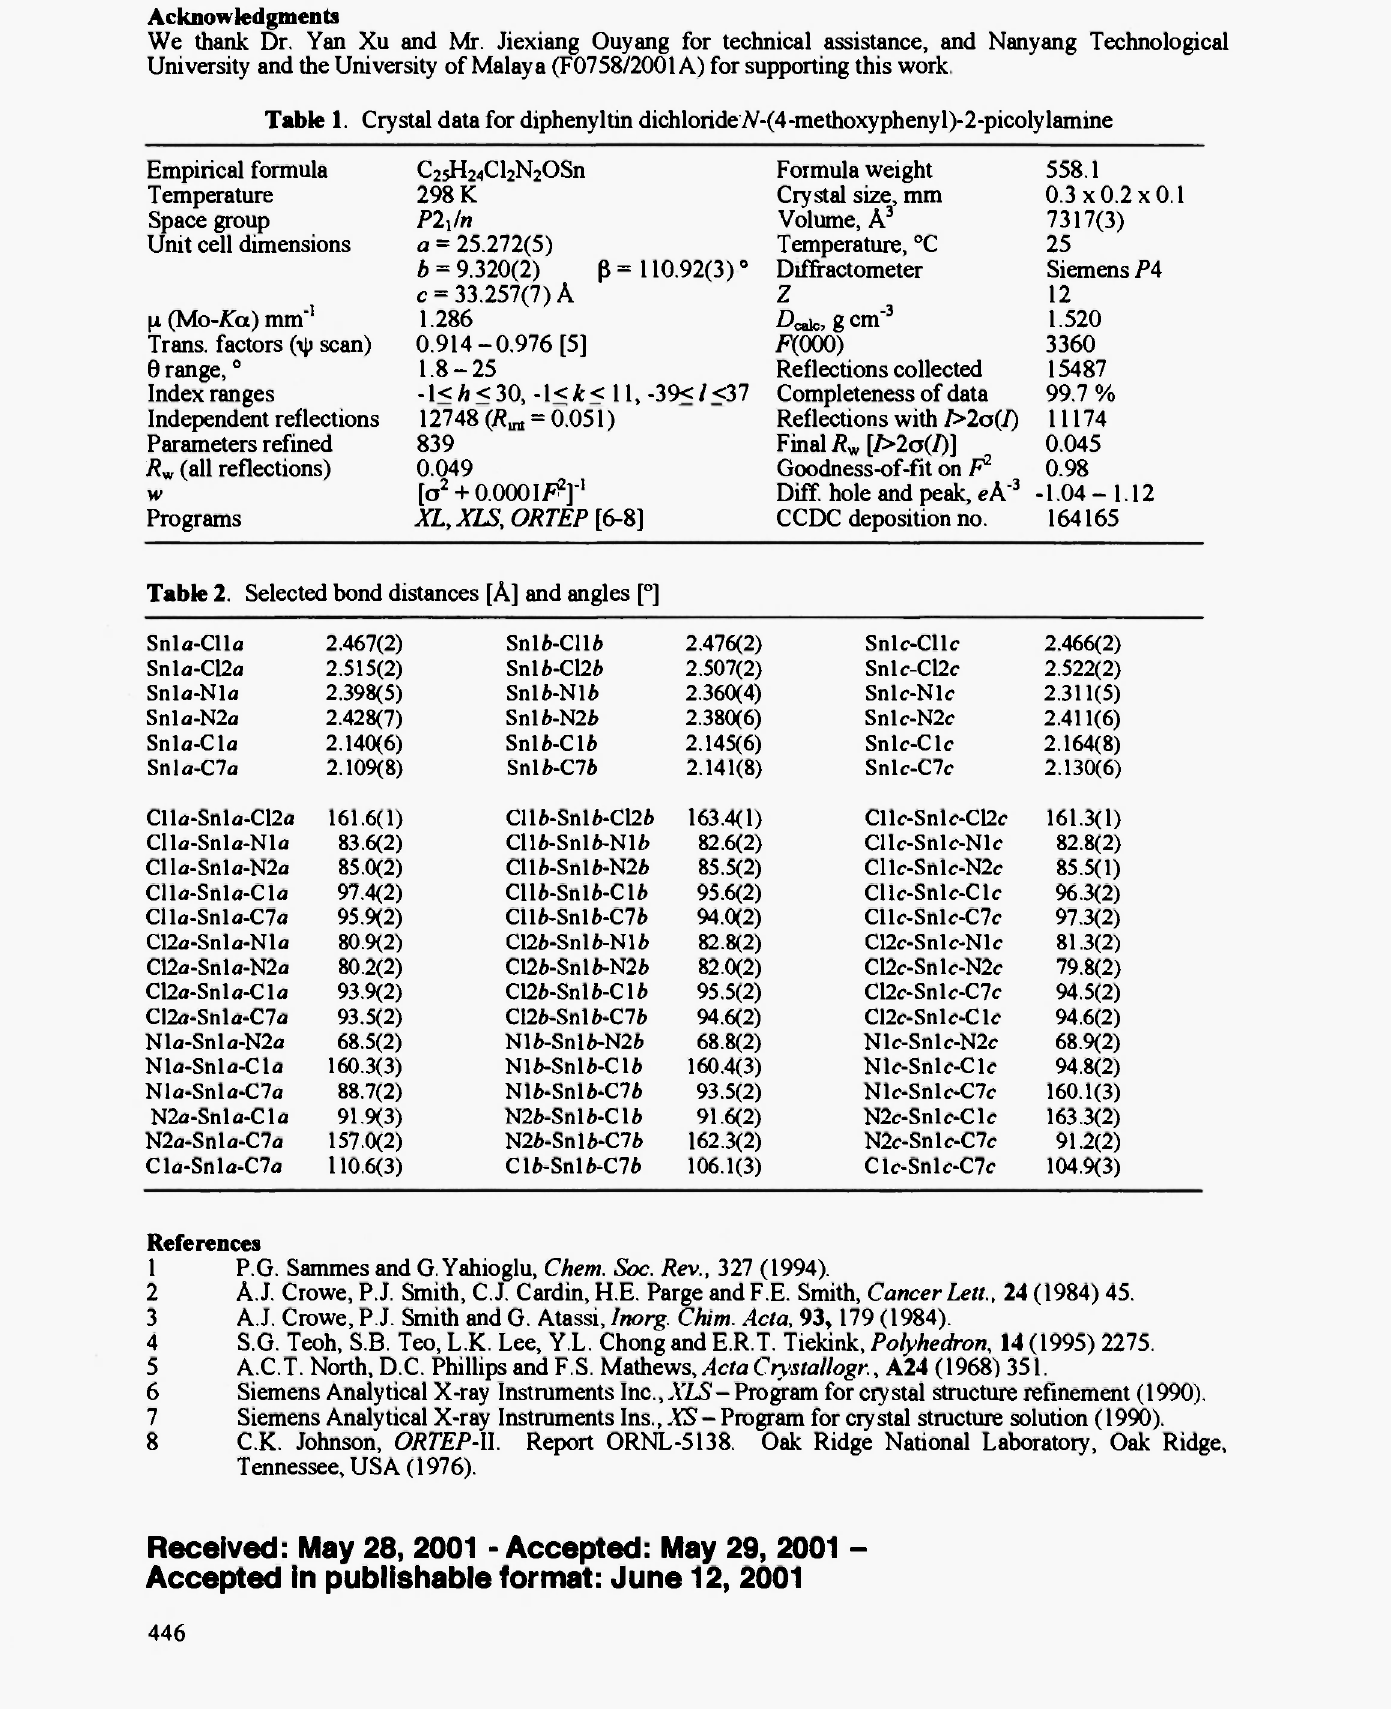
Table 2. Selected bond distances [A] and angles